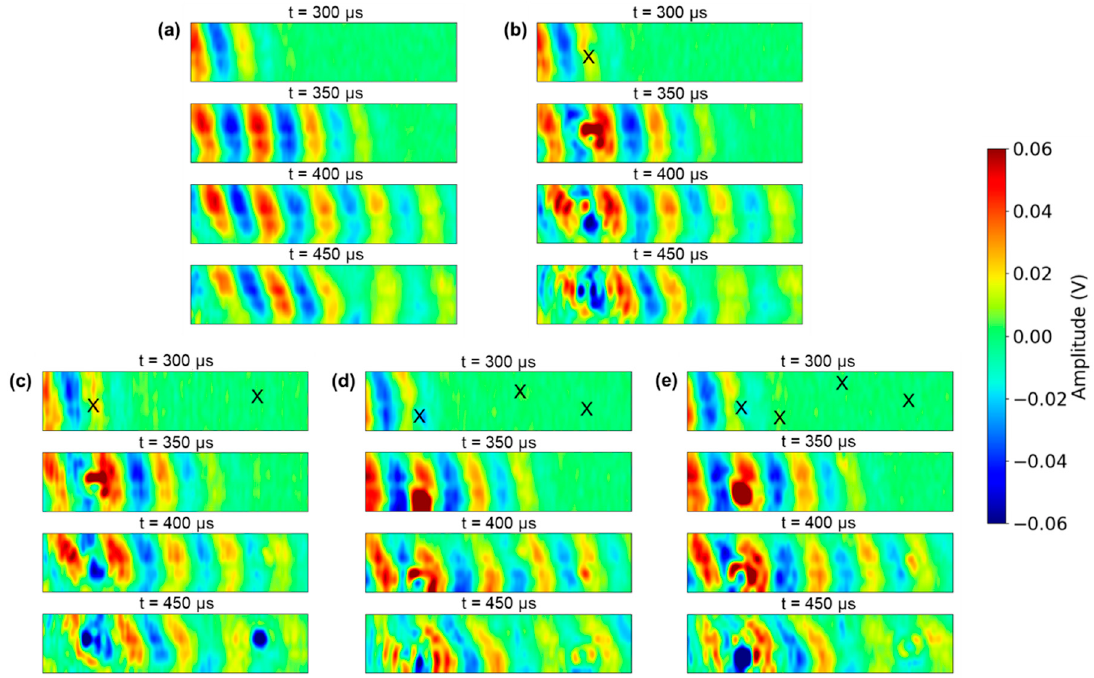
Figure 4. Measured time-space domain wavefield data: ( a ) Case 0 (pristine), ( b ) Case 1 (D1 only), ( c ) Case 2 (D1 and D2), ( d ) Case 3 (D1 to D3) and ( e ) Case 4 (D1 to D4). The wavefield images each represent a 250 mm (horizontal) × 49 mm (vertical) scan area. ‘X’ indicates an impact damage location.